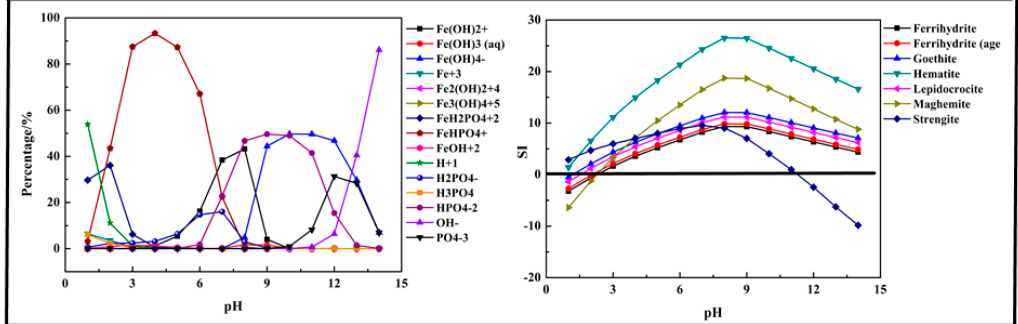
Figure 2. Percentage of species in the Fe-P-H 2 O system at 298 K at ranged pH ((P) = 0.01 mol/L, (Fe 3+ ) = 0.01 mol/L).